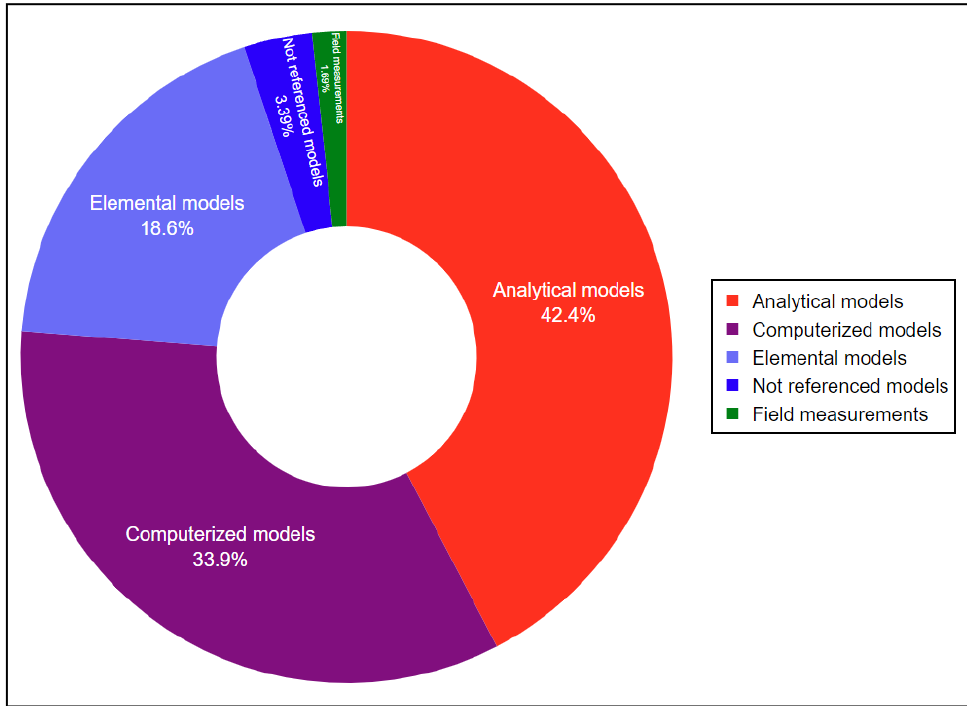
Figure 4. Distribution of the fuel consumption and emissions models in percentage.